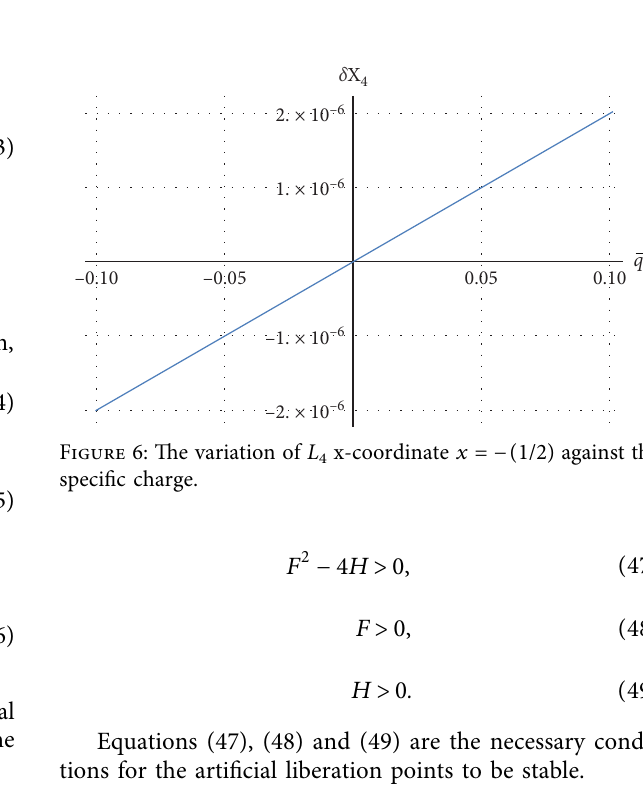
Figure 5: The variation of L specific